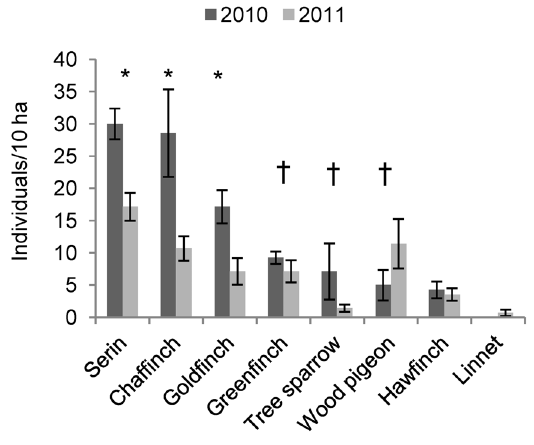
Figure 4. Density estimation of the main avian elm seed predators for two consecutive springs. Significant ( P , 0.05) and marginally significant differences ( P , 0.10) between years for each species are indicated by (*) and ( { ), respectively.